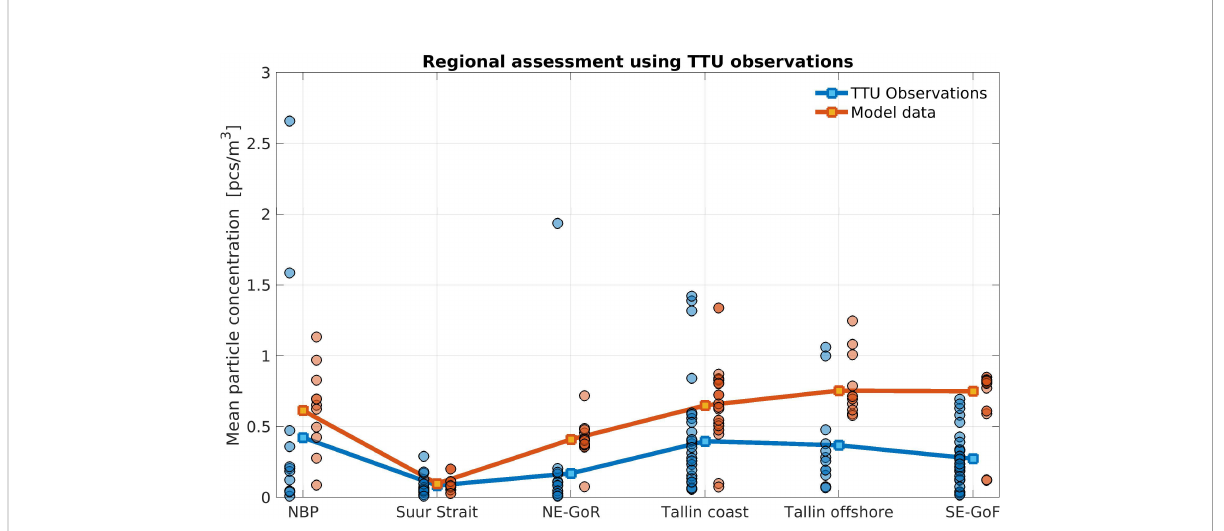
FIGURE 10 Comparison of modeled (red) and observed (blue) data sets from TalTech in Estonia. Regional averages are shown as solid lines, whereas individual observations and model data points are presented as red and blue dots.